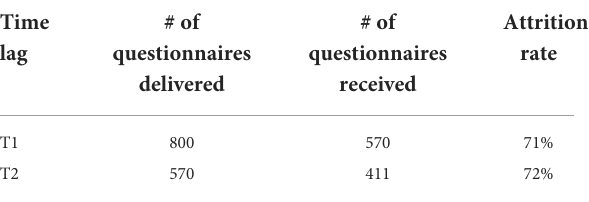
TABLE 2 Attrition rate of respondents. TABLE 3 Sample characteristics ( n =